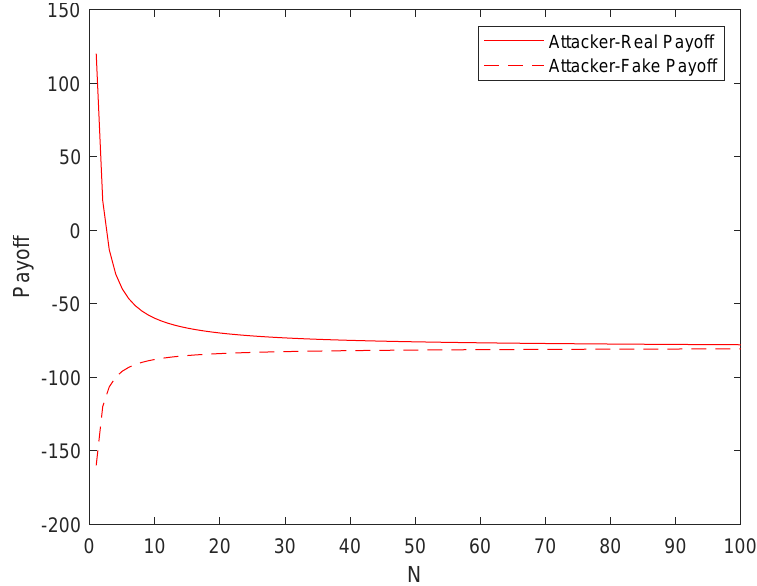
Figure 7. Payoff curves of the attacker.